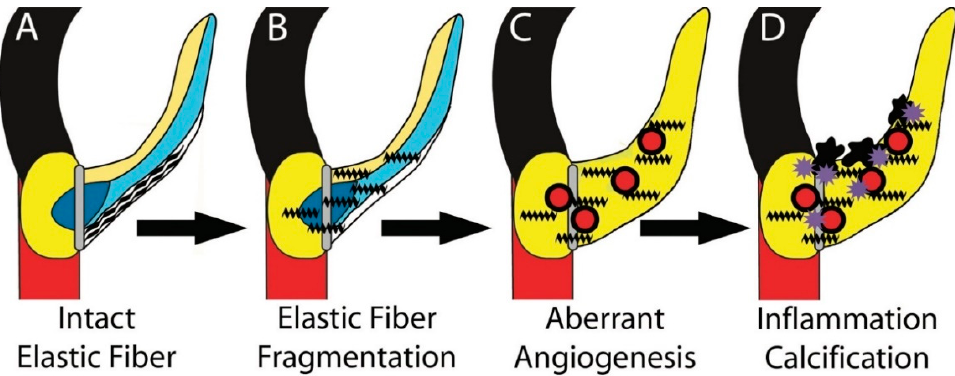
Figure 5. Model of early EFF and angiogenesis preceding inflammation in AVD. Intact elastic fibers are organized as filaments in the normal ventricularis cusp layer (wavy black lines, A ). Faulty elastic fiber assembly and/or imbalance between elastases and elastase inhibitors results in EFF (jagged black lines, ( B ). EFF causes angiogenesis (red circles), increased cell proliferation, and matrix accumulation ( C ), ultimately leading to inflammation (purple stars) and calcification (black nodules, D ).